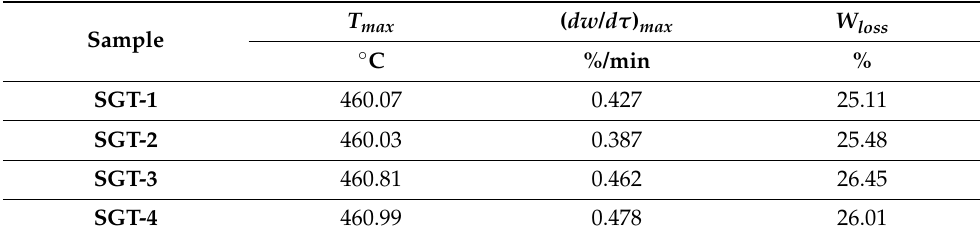
Table 1. Summary of TG and DTG